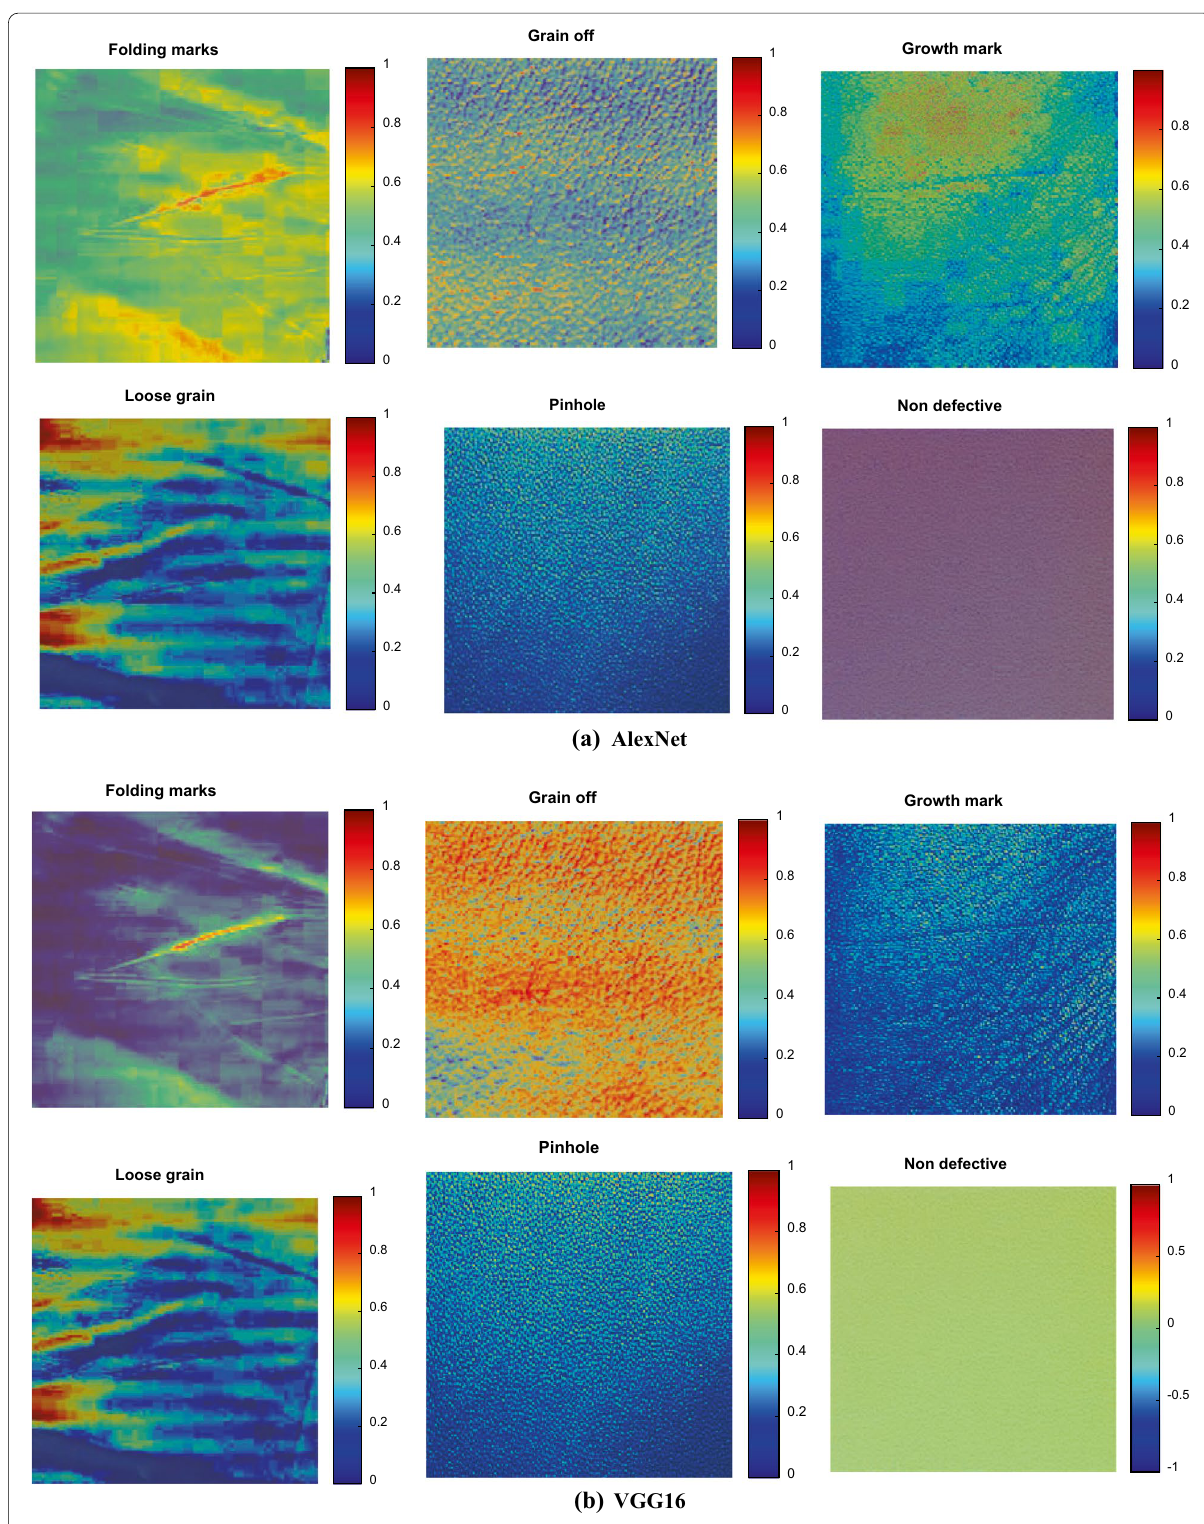
Fig. 14 Identified discriminative regions for different classes of the leather images using deep learning neural